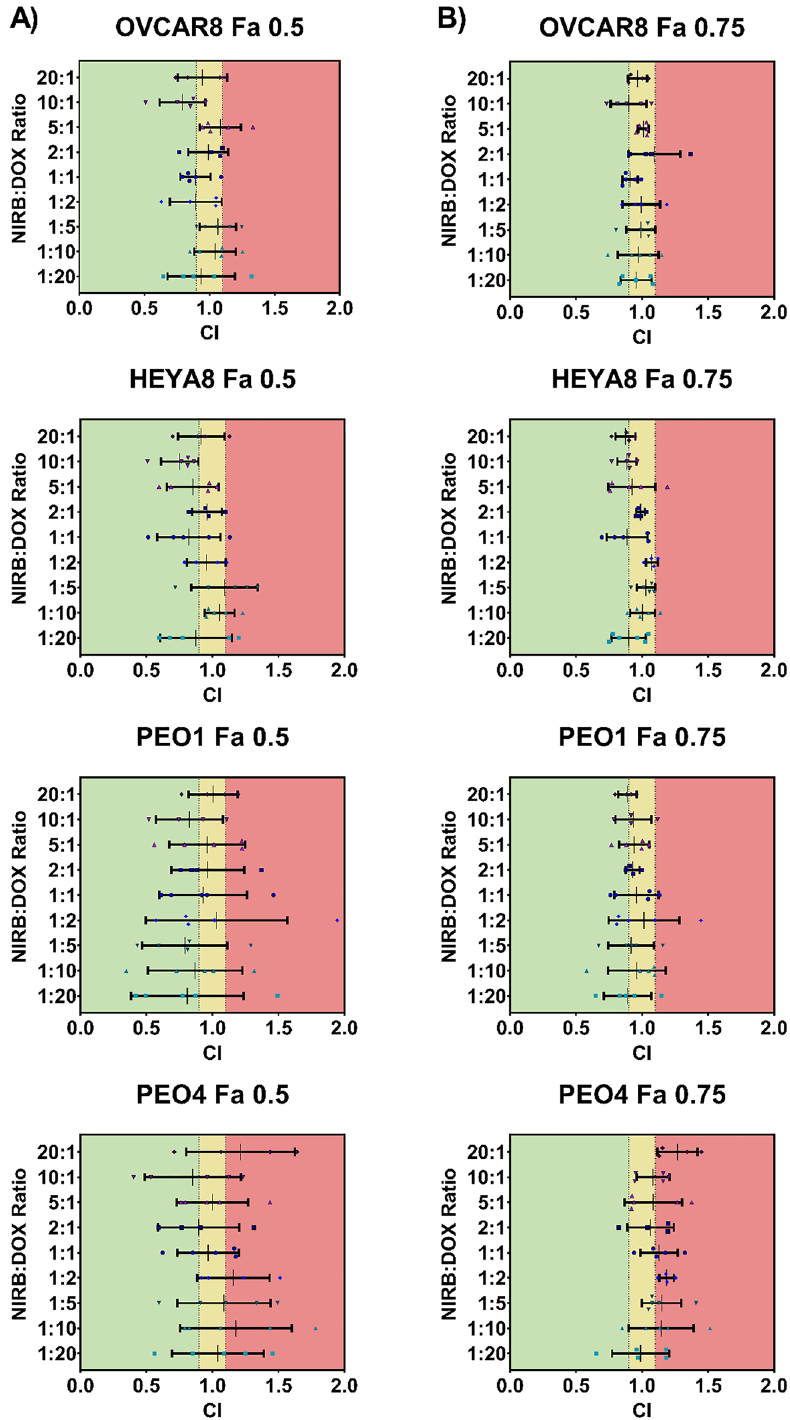
Figure 2. Scatter plot showing mean ± SD CI values at ( A ) Fa = 0.5 and ( B ) Fa = 0.75 for treatments of NIRB:DOX at varying relative molar ratios on a panel of four HGSOC cell lines. CI values ≤ 0.9 indicate synergistic effects (green), 0.9 > CI < 1.1 indicate additive effects (yellow), and CI ≥ 1.1 indicate antagonistic effects (red). The 10:1 molar ratio is shown to have consistent synergistic/additive effects in all cell lines at both Fa = 0.5 and Fa = 0.75 except for PEO4, wherein the combination of NIRB and DOX seems to exhibit a wide range of values including those indicative of antagonism across the various molar drug ratios. CI values were calculated using CompuSyn